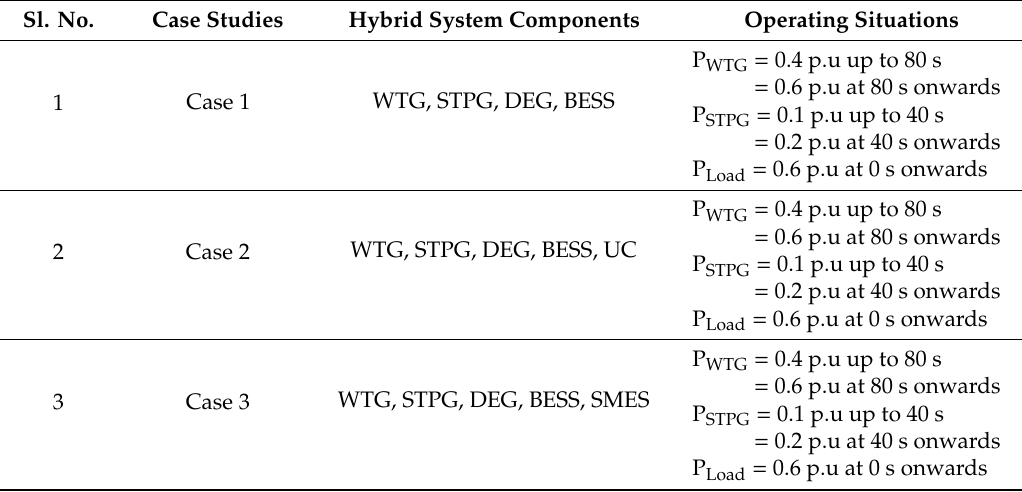
Figure 2. Linearized frequency response model consisting of a wind generation (WTG)–STPG–diesel generation (DEG)–BESS-based autonomous hybrid energy system. Table 4. Operating conditions for the simulation studies.